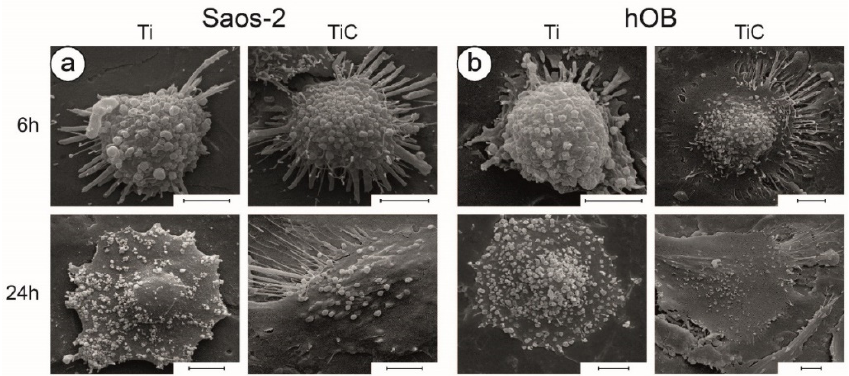
Figure 8. Investigation of cell morphology by SEM. Panel ( a ): SEM micrographs showing the morphology of Saos-2 cells grown for 6 h and 24 h on uncoated (Ti) and TiC-coated (TiC) titanium disks. Panel ( b ): similar analysis on hOB cells. The images reveal that both types of cells are richer in philopodia and lamellipodia, and better adhered to the substrate when grown either for 6 or 24 h on the TiC-coated titanium disks compared to the uncoated. In each figure, the bars represent 5 µm. Reprinted from [63] . Copyright (2015), with permission from Elsevier.